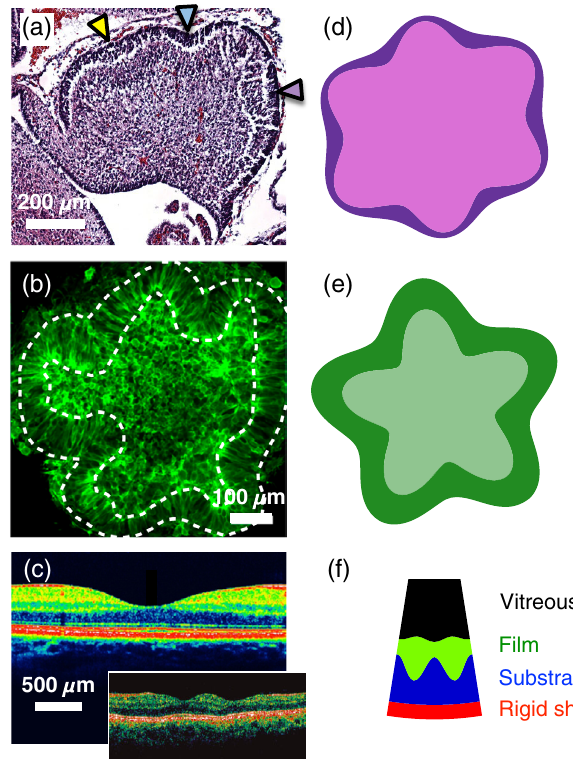
FIG. 2. Certain morphogenesis problems exhibit out-of- phase thickness oscillations, at odds with an elastic wrinkling mechanism. (a) Midsaggital section of a mouse cerebellum at 17.5 embryonic days, reprinted from Fig. 5 in Ref. [22] with permission from Springer Nature. Arrows are from the original image and mark positions of developing invaginations. (b) þ Blebbistatin organoid, reprinted from Fig. 4(a) in Ref. [10] with permission from Springer Nature. (c) Cross-section of the foveal pit in a human retina, reprinted from Fig. 13(b) in Ref. [23] with permission from Webvision and the author. The green and blue layers are the ganglion cell and photoreceptor layers, respectively. The inset shows a rare double fovea in a human retina (double foveas are typical in some bird species), reprinted from Ref. [24] with permission from the American Medical Association. (d) Polar plot of r ð θ Þ and r ð θ Þ − t ð θ Þ from Eqs. (6) and (7) with ϵ ¼ 0 . 6 , c ¼ T=a ¼ t 0 =a ¼ 0 . 1 , k t = β ¼ 31 . 3 , ϕ ¼ π , e ¼ 0 . 5 . (e) Same as (d) but with ϵ ¼ 0 . 9 , c ¼ 0 . 067 , T=a ¼ 0 . 05 , t =a ¼ 0 . 7 , k = β ¼ 15 . 6 , ϕ ¼ e ¼ 0 . (f) Polar plot 0 t of r ð θ Þ and r ð θ Þ − t ð θ Þ from Eqs. (11) and (12) with ϵ ¼ − 0 . 2 , c ¼ 0 . 3 , T=a ¼ t =a ¼ 1 , R=a ¼ 20 , k = β ¼ 1770 , ϕ ¼ e ¼ 0 0 t